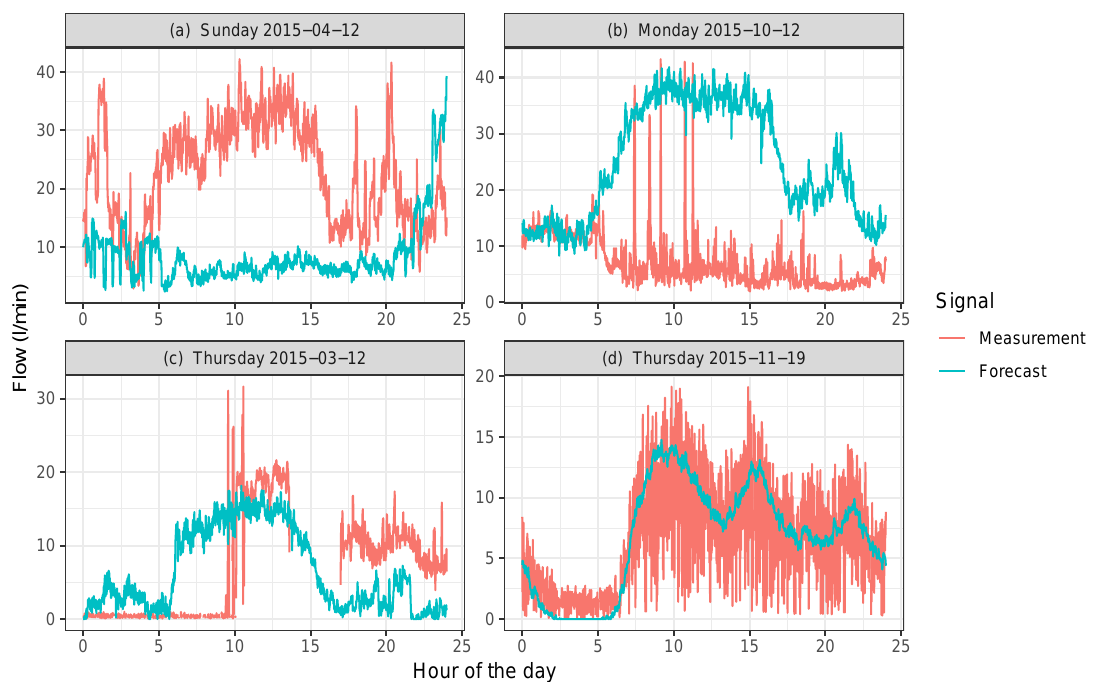
Figure 6. Examples of troublesome signals. In ( a ), the forecasted day was on Sunday, 12 April 2015, for the industrial site. For this site, Saturdays were very similar, and Sundays differed depending on other factors (e.g., the time of the year). This led to an improper forecasting since the k Saturdays closest to 11 April 2015 were not followed by Sundays similar to the forecasted day. In ( b ), the forecast was for Monday, 2 November 2015, for the industrial site. This day was a holiday. In this case, since the day before was a Sunday, the predicted values were the average of k normal Mondays, which obviously had a very different behavior. In ( c ), the effect of missing data in both the prediction and query days is visible. When there were missing data in the query day, since only the remaining data were considered, the neighbors were improperly obtained, and thus, one might obtain a misleading neighbor, which would yield erroneous forecasting results. When data are missing for the forecasting day, there cannot be accurate predictions. In ( d ), the forecasting for the downtown site on 19 November 2015 is depicted. The water flow measurements showed a very large random component, which greatly increased its variance. However, the general pattern of the series was well